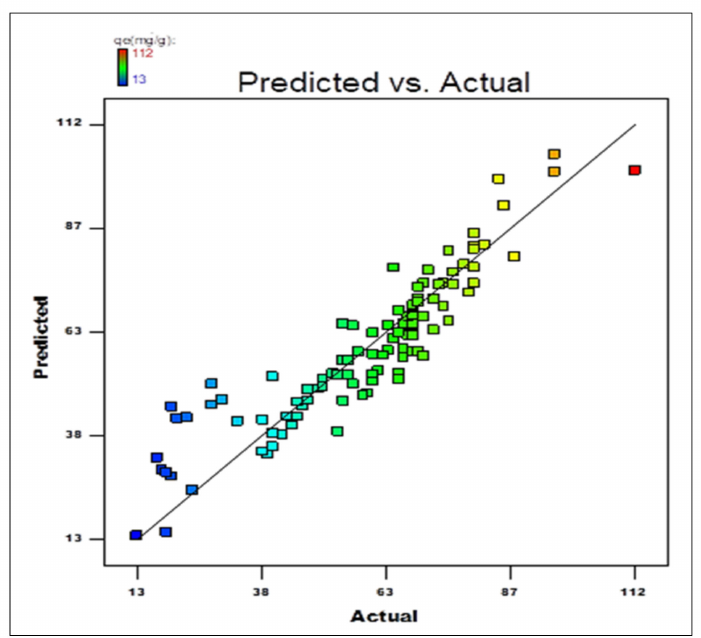
Figure 13. The calculated response against the experimental value obtained for adsorption capacity of